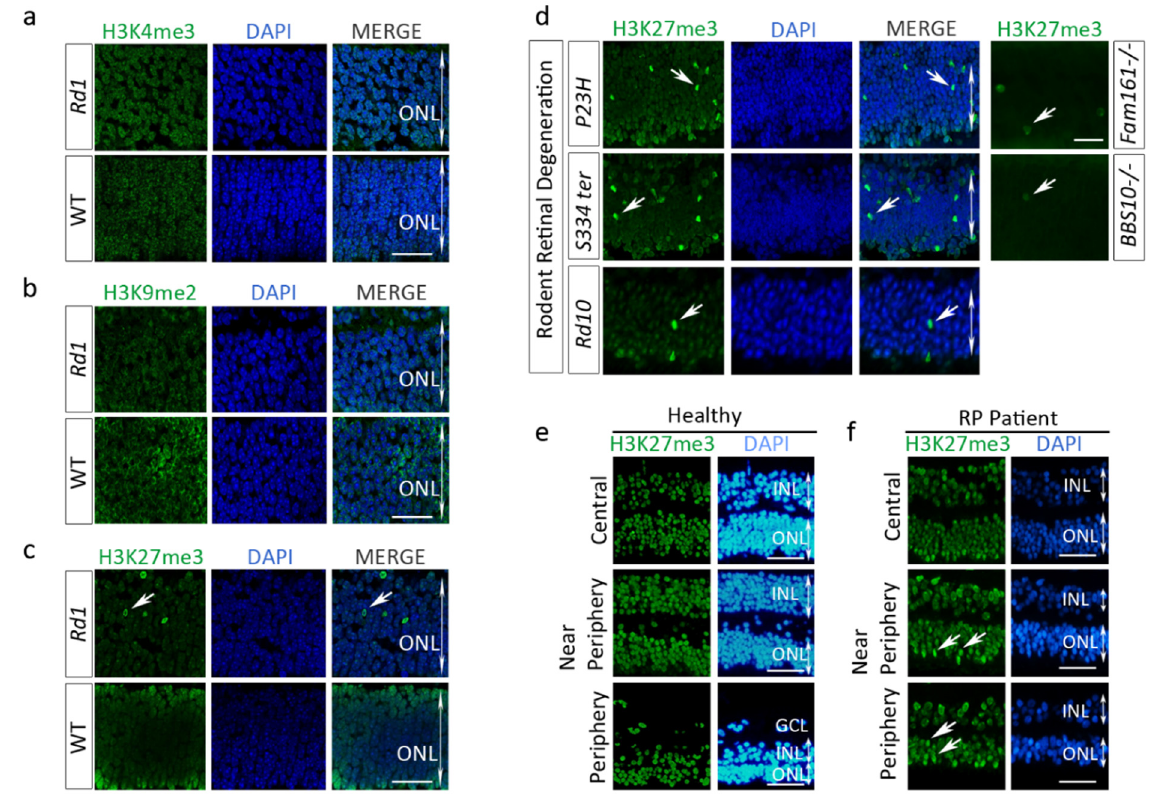
Figure 2. High epigenetic mark accumulation is specific to H3K27me3 in murine models of retinal degeneration and high level of H3K27me3 mark is also detected in human photoreceptors from one retinitis pigmentosa (RP) patient. ( a , b ) No obvious differences in H3K4me3 or H3K9me2 marks were observed between WT and Rd1 retinas at PN12, whereas some photoreceptor nuclei expressed H3K27me3 h in the Rd1 retina ( c ). ( d ) H3K27me3 accumulation was also observed in two rodent models of a dominant form of inherited retinal degeneration (mouse rhodopsin P23H and rat S334ter ) as well as two mouse models of photoreceptor ciliopathy ( Fam161a − / − and BBS10 − / − ), and in another model of PDE6B deficiency, the Rd10 mouse. Retina sections from one human healthy donor ( e ) and one RP patient ( f ) with moderate degeneration in the central retina and advanced cell loss in the periphery. Increased H3K27me3 h was much more predominant in areas with advanced retinal degeneration (periphery, arrows). Note that in retina areas with normal photoreceptor architecture, few nuclei also contain the H3K27me3 mark (arrows). Calibration bar: 40 μ m ( a – c ) and 40 μ m for ( e , f ), respectively.